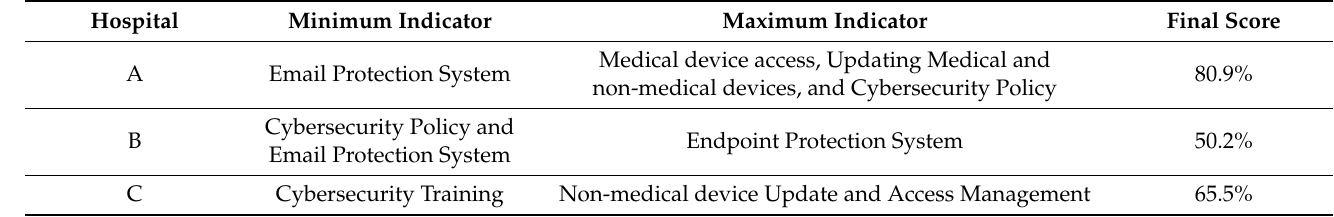
Table 3. The results of the evaluation model using the three hospitals’